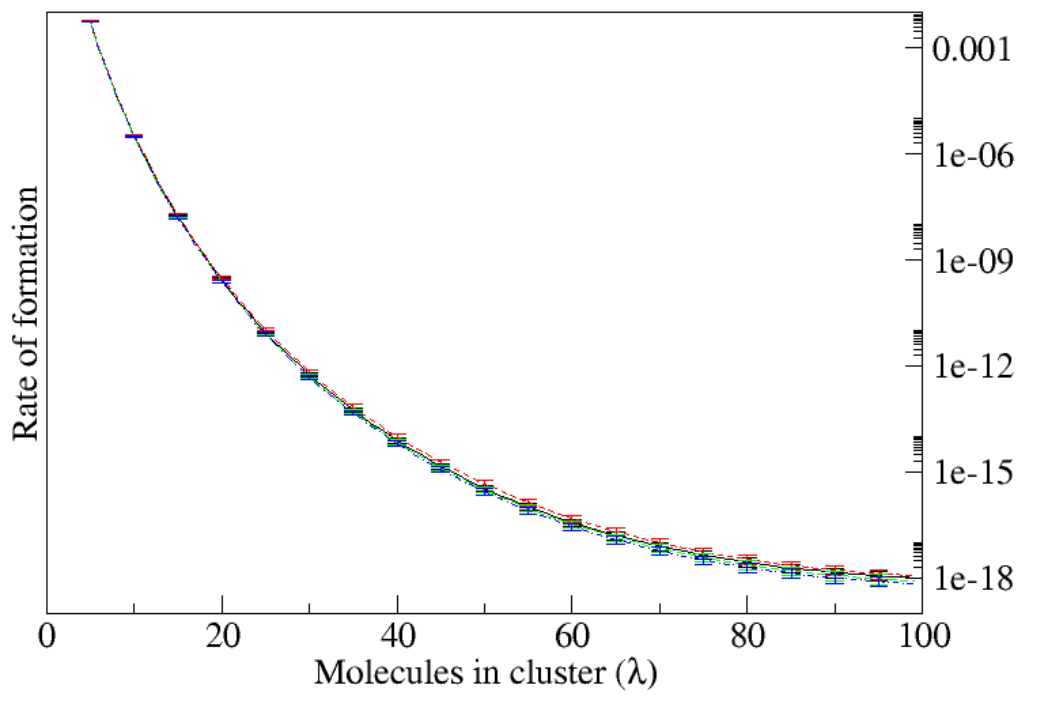
= a 2 / D ) of different sizes (horizontal axis) for substrates 0